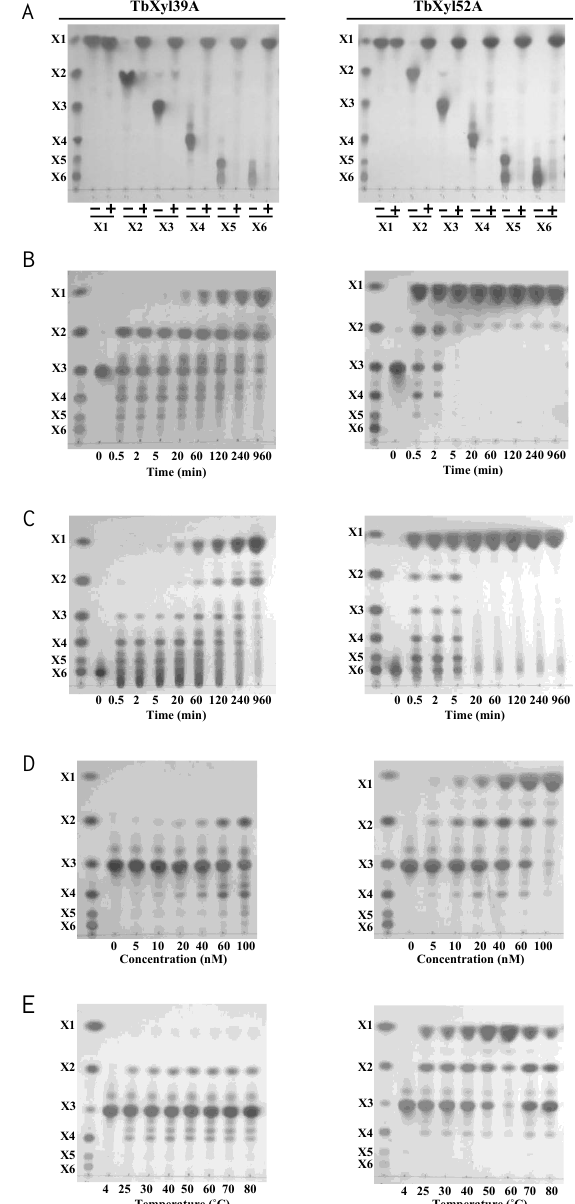
Figure 4. TbXyl39A and TbXyl52A behave differently during hydrolysis of xylo-oligosaccharides. ( A ) Reaction of xylose and xylo-oligosaccharides with TbXyl39A and TbXyl52A. The reactions were carried out by incubating 1 µM of TbXyl39A or TbXyl52A with 1 mg/mL of xylose or xylo-oligosac- charides (X2 – X6) at 60 °C in a citrate buffer for 20 h. ( B ) Hydrolysis of xylotriose by TbXyl39A or TbXyl52A. One mg/mL of xylotriose was incubated with 100 nM of TbXyl39A or TbXyl52A at 60 °C in a citrate buffer. At different time intervals (0, 0.5, 2, 5, 20 min, 1, 2, 4, and 16 h), 30 µL samples were taken out and immediately heated at 100 °C to inactive the enzymes. ( C ) Hydrolysis of xylo- hexaose by TbXyl39A or TbXyl52A. The experiments were carried out as described for xylotriose hydrolysis, except with xylohexaose replacing xylotriose. ( D ) Hydrolysis of xylotriose by TbXyl39A or TbXyl52A with increasing enzyme concentrations. One mg/mL of xylotriose was incubated with 0, 5, 10, 20, 40, 60, or 100 nM of TbXyl39A (or TbXyl52A) at 60 °C in a citrate buffer for 2 min. ( E ) Hydrolysis of xylotriose by TbXyl39A or TbXyl52A at different temperatures. One mg/mL of xy- lotriose was incubated with 100 nM of TbXyl39A (or TbXyl52A) at 4, 22, 30, 40, 50, 60, 70, or 80 °C in a citrate buffer for 5 min, respectively. All reaction products were dried and dissolved in 4 µL of H 2 O. One µL of the end products was analyzed by thin-layer chromatography. Xylose (X1) and xylo-oligosaccharides (X2 – X6) were used as standards.